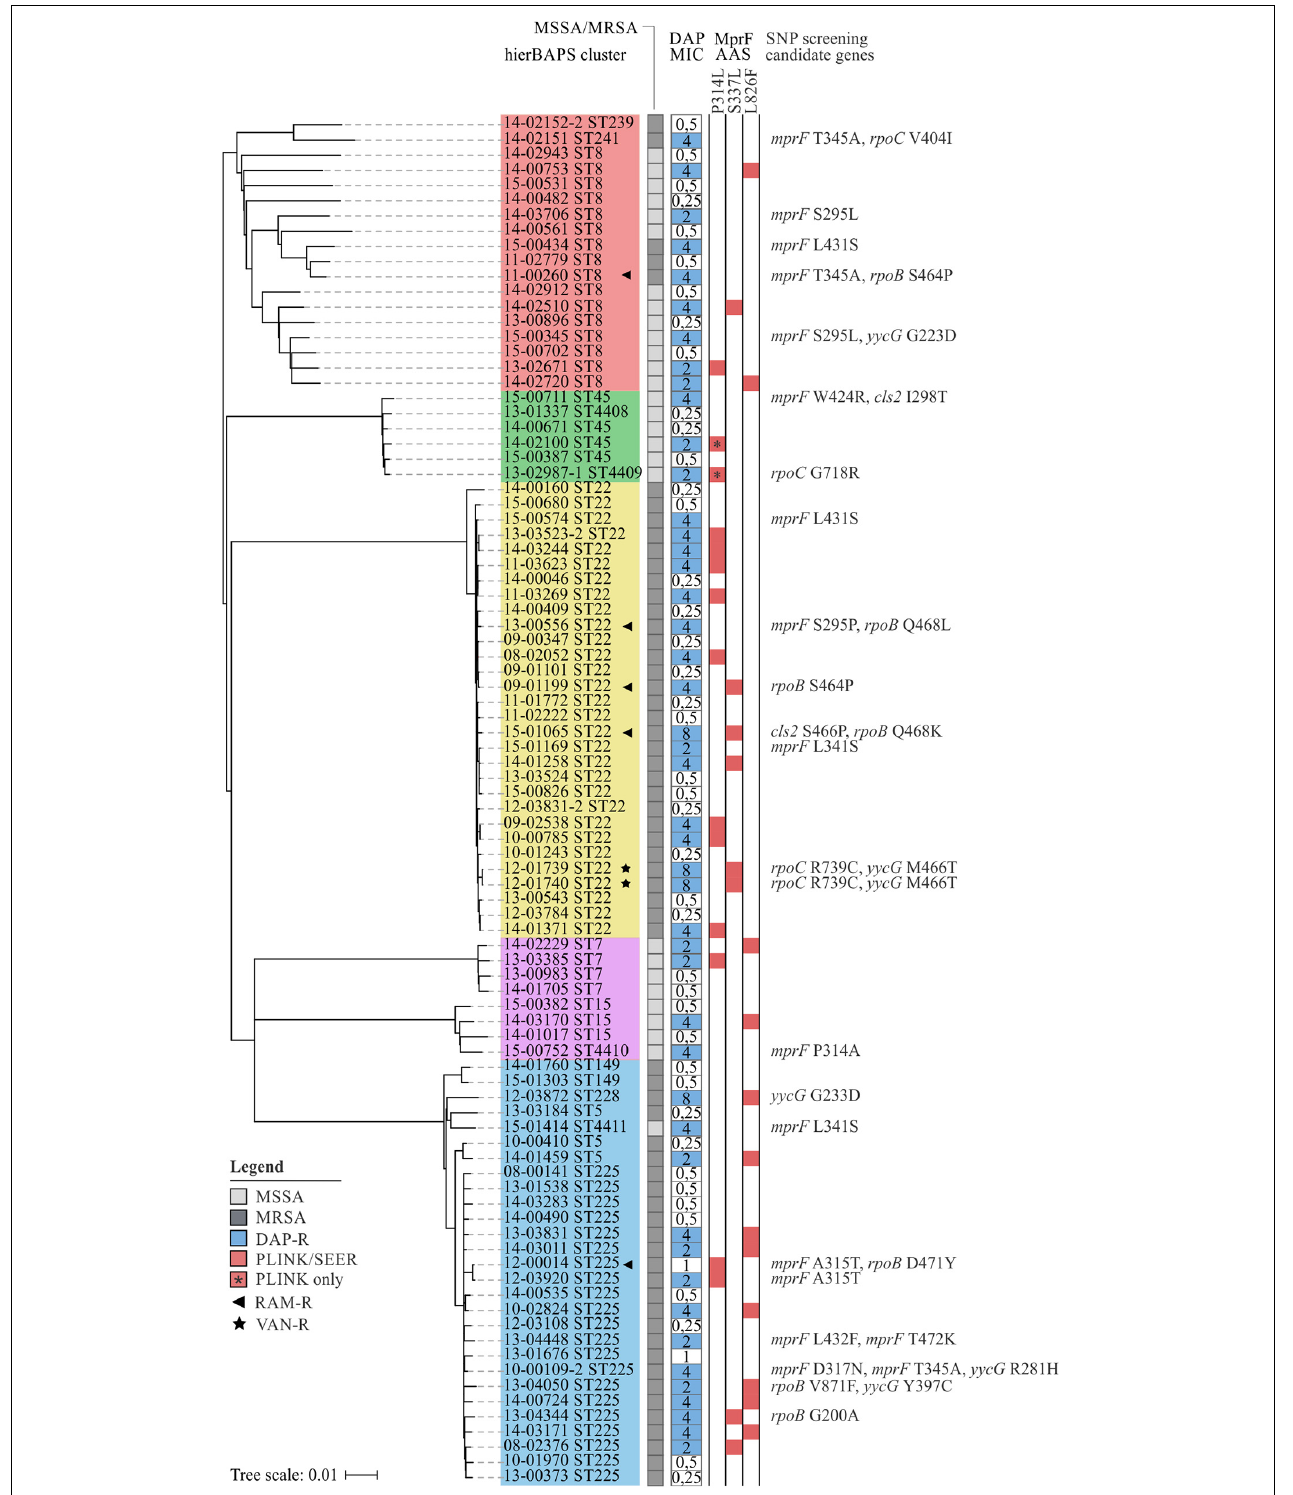
FIGURE 3 | Phylogenetic relation and genotypes of DAP-R S. aureus included in this study. On the left, a neighbor-joining tree based on 7.342 SNPs represents the phylogenetic relatedness of 90 S. aureus isolates. Identified hierBAPS subclusters are color-coded. Dark and light shaded grayish boxes represent MRSA and MSSA isolates, respectively. Blue boxes point to DAP resistance. Corresponding numbers refer to DAP MICs as determined by BMD. Red-shaded squares indicate the presence of AAS that could be identified by SEER and/or PLINK analysis. On the right, AAS in candidate genes are shown as identified by the use Mesquite analysis.